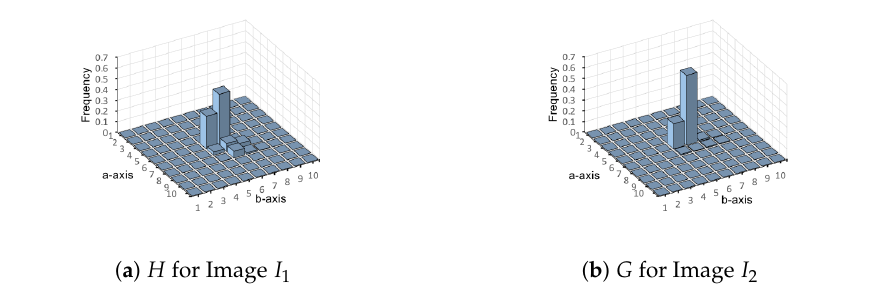
Figure 3. Original color histograms (10 × 10